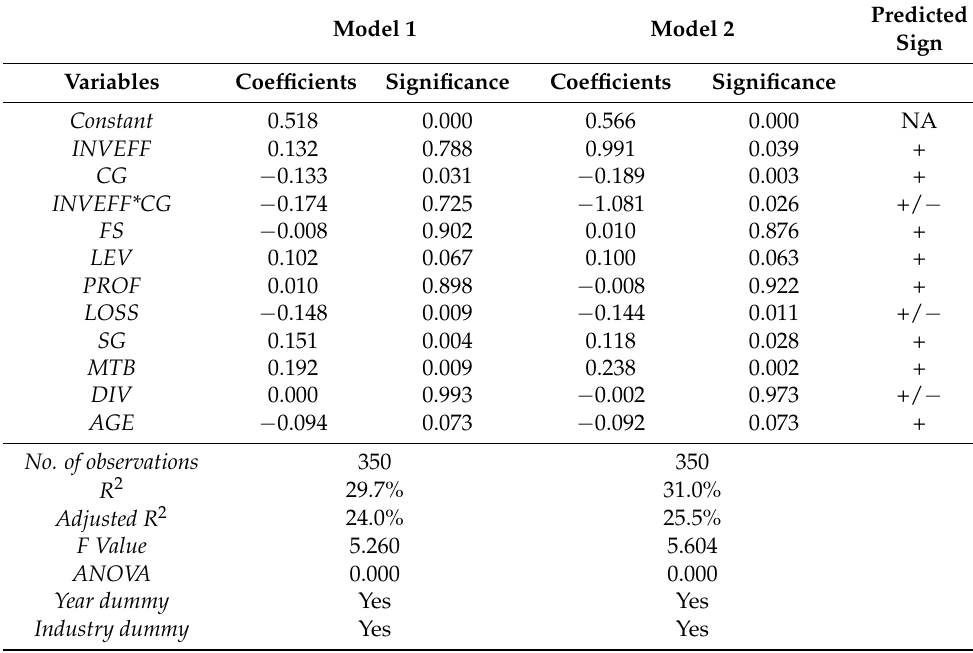
Table 6. Investment efficiency and disclosure